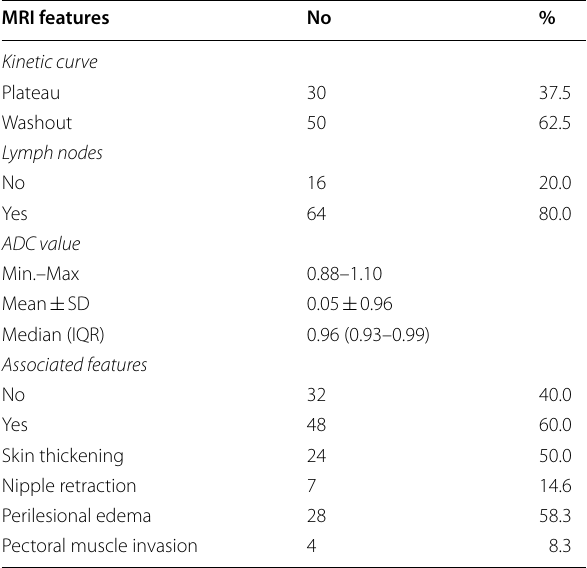
Table 2 Distribution of the studied cases according to different MRI features ( n =